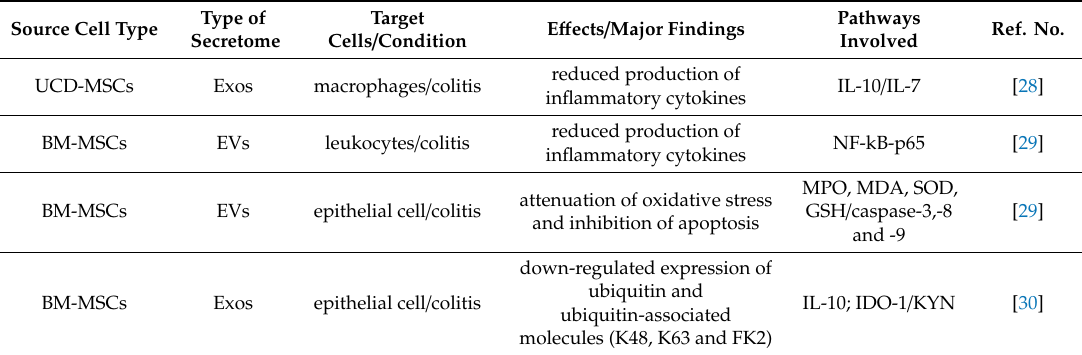
Table 4. Therapeutic potential of MSC-derived secretome in attenuation of inflammatory bowel diseases. Type of Source Cell Type